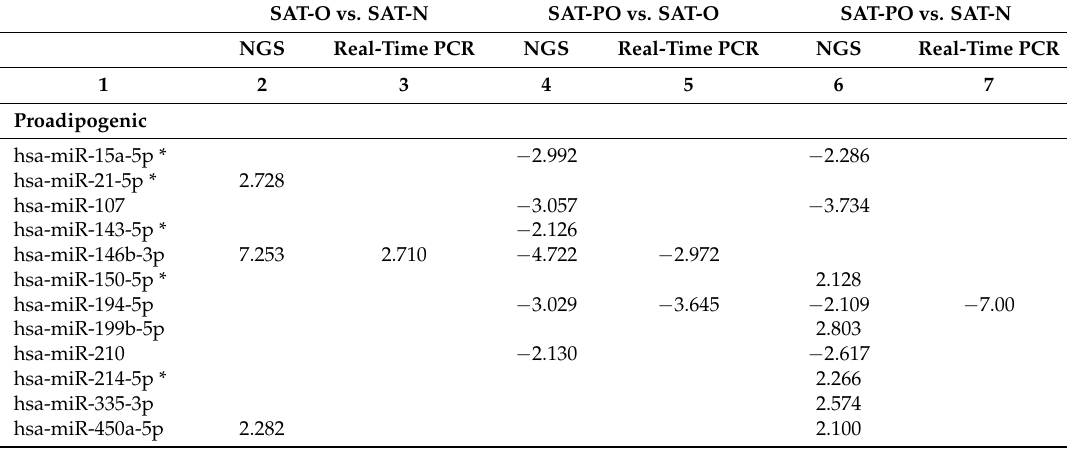
Table 1. Fold changes of microRNAs (miRNAs) differentially expressed in subcutaneous adipose tissue (SAT) of obese individuals before (O) and after weight loss (PO), as well as of normal-weight subjects (N) assessed by the next generation sequencing (NGS) and real-time PCR methods. SAT-O vs. SAT-N SAT-PO vs. SAT-O SAT-PO vs. SAT-N NGS Real-Time PCR NGS Real-Time PCR